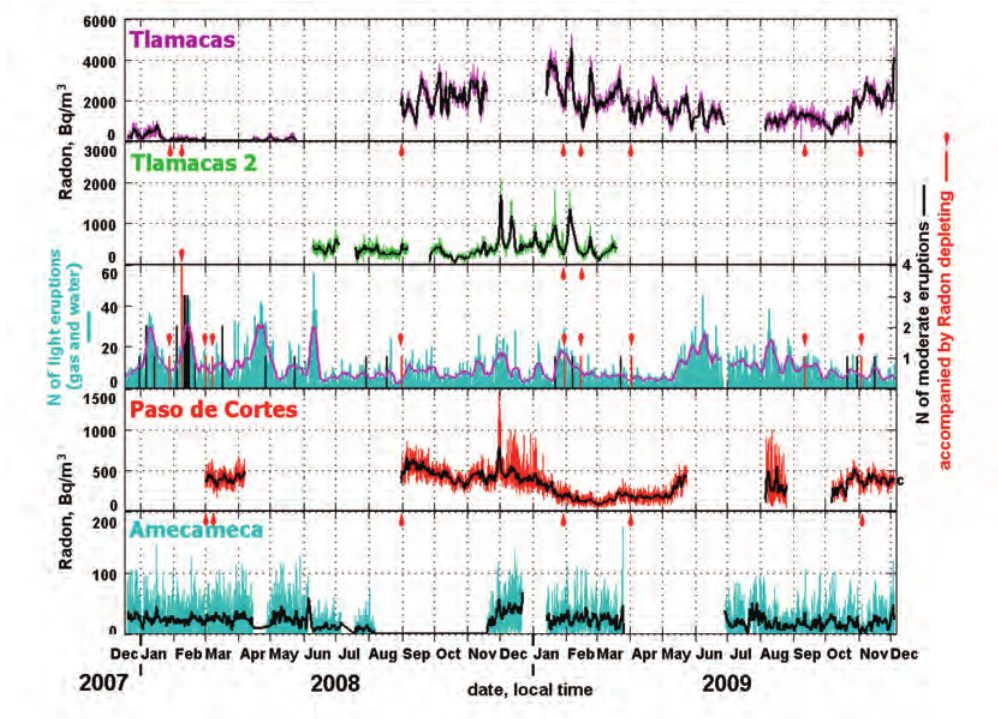
Figure 2. Radon emission monitoring at the three volcano sites. Top to bottom: Tlamacas, Tlamacas 2, Paso de Cortes and Amecameca referent site. Monitoring from December 2007 to December 2009. Middle panel: Volcano eruptions. Blue bars, eruptions of gas and water; black bars, moderate eruptions; red bars and arrows, moderate eruptions where radon decreases were